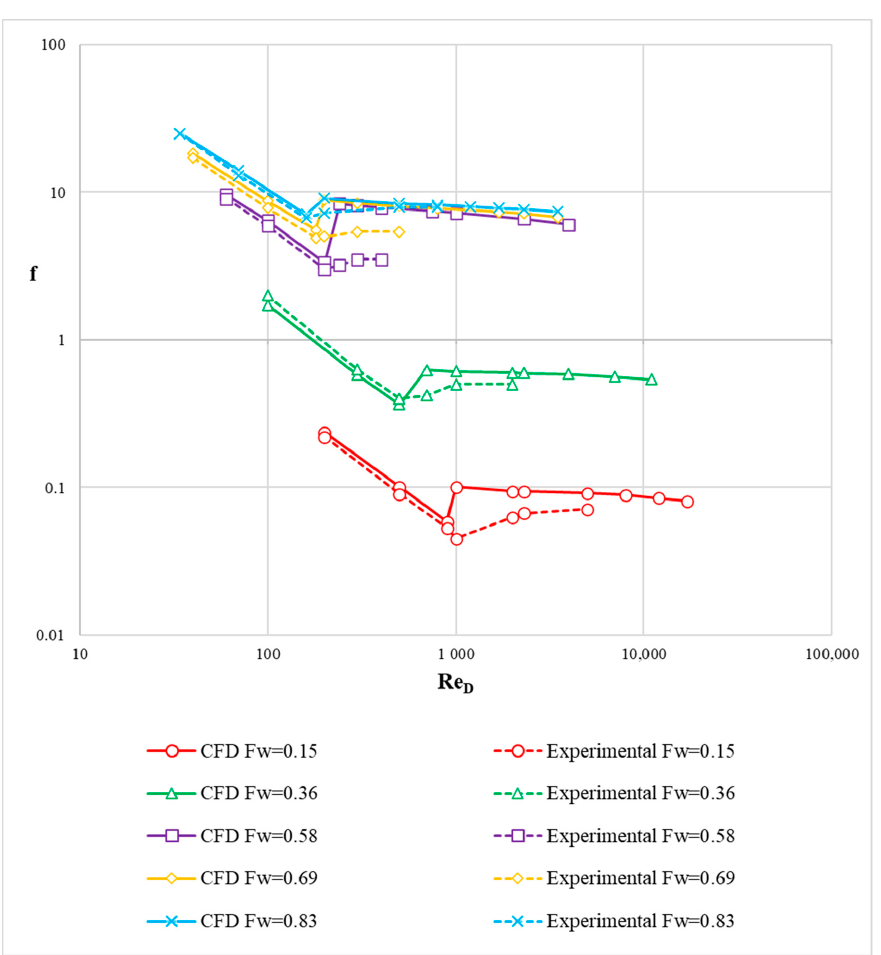
Figure 7. Comparison of experimental and simulated results of friction factor for wavy-walled